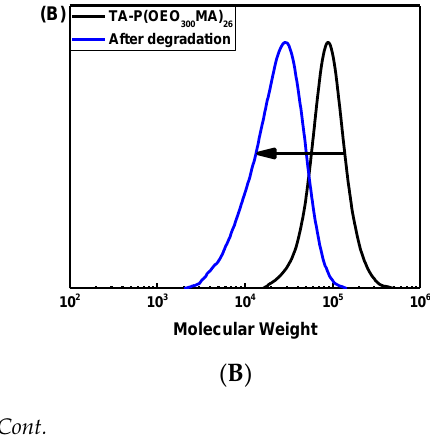
Polymer arms post degradation